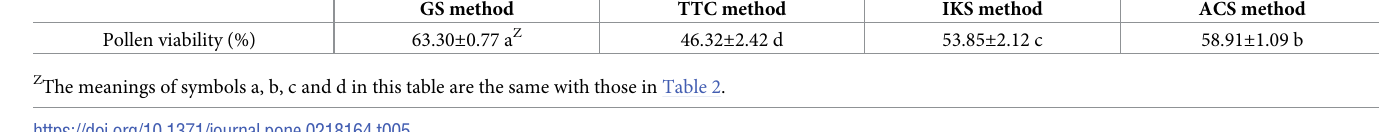
Fig 6. Observation of pollen germination of ‘Hang Baishao’ with the extension of culture duration. (A): comparison of pollen germination rates between media 2 and 3 (Table 2); (B) germination and tube elongation of pollens cultured on medium 2 (Table 2, no CaCl 2 ) for 1.0 h; (C): 3.0 h; (D): 5.0 h; (E): 6.0 h.